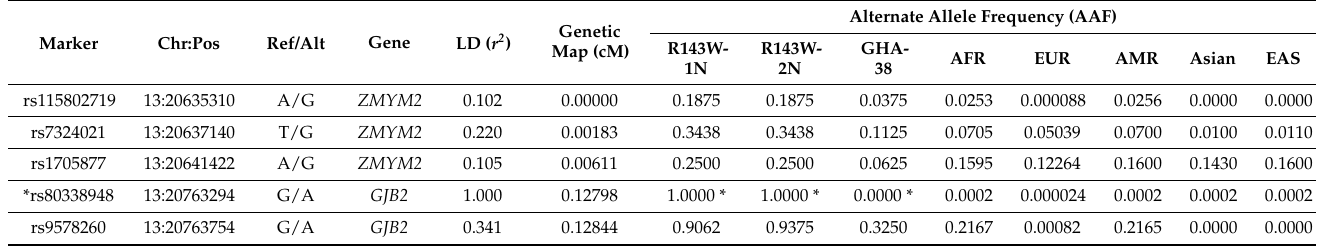
Table 1. Features of linkage disequilibrium-selected variants for the age estimate and haplotype analysis.